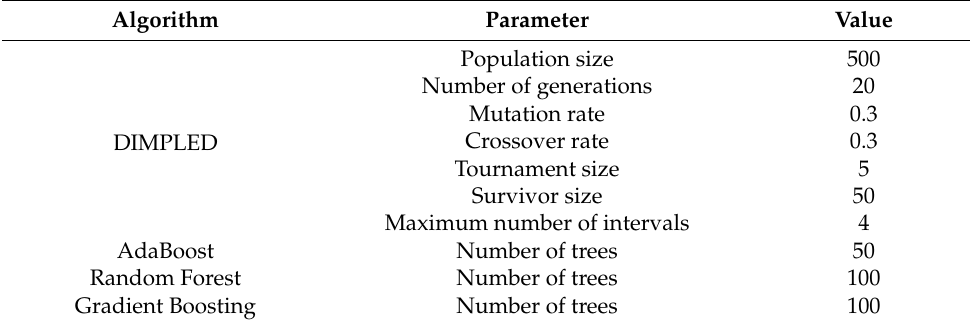
Table 5. Parameters for DIMPLED and other tree-based